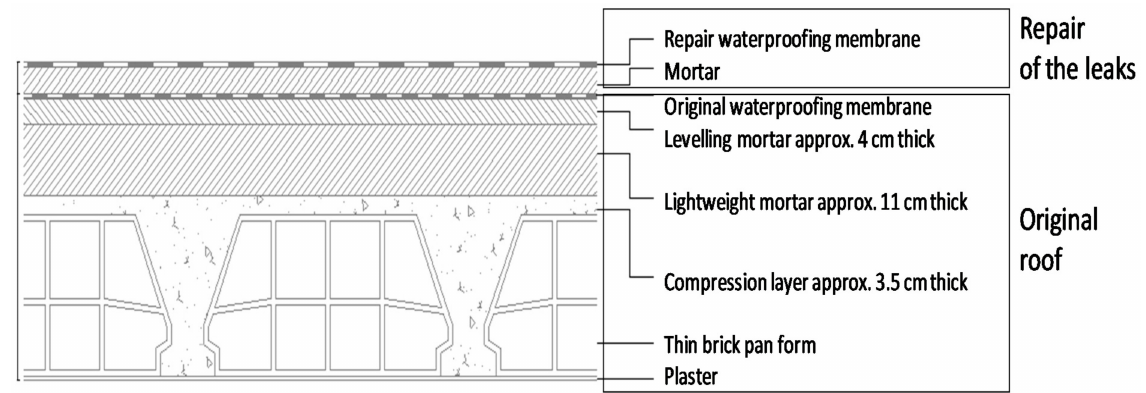
Figure 2. Cross-sectional schematic drawing of the